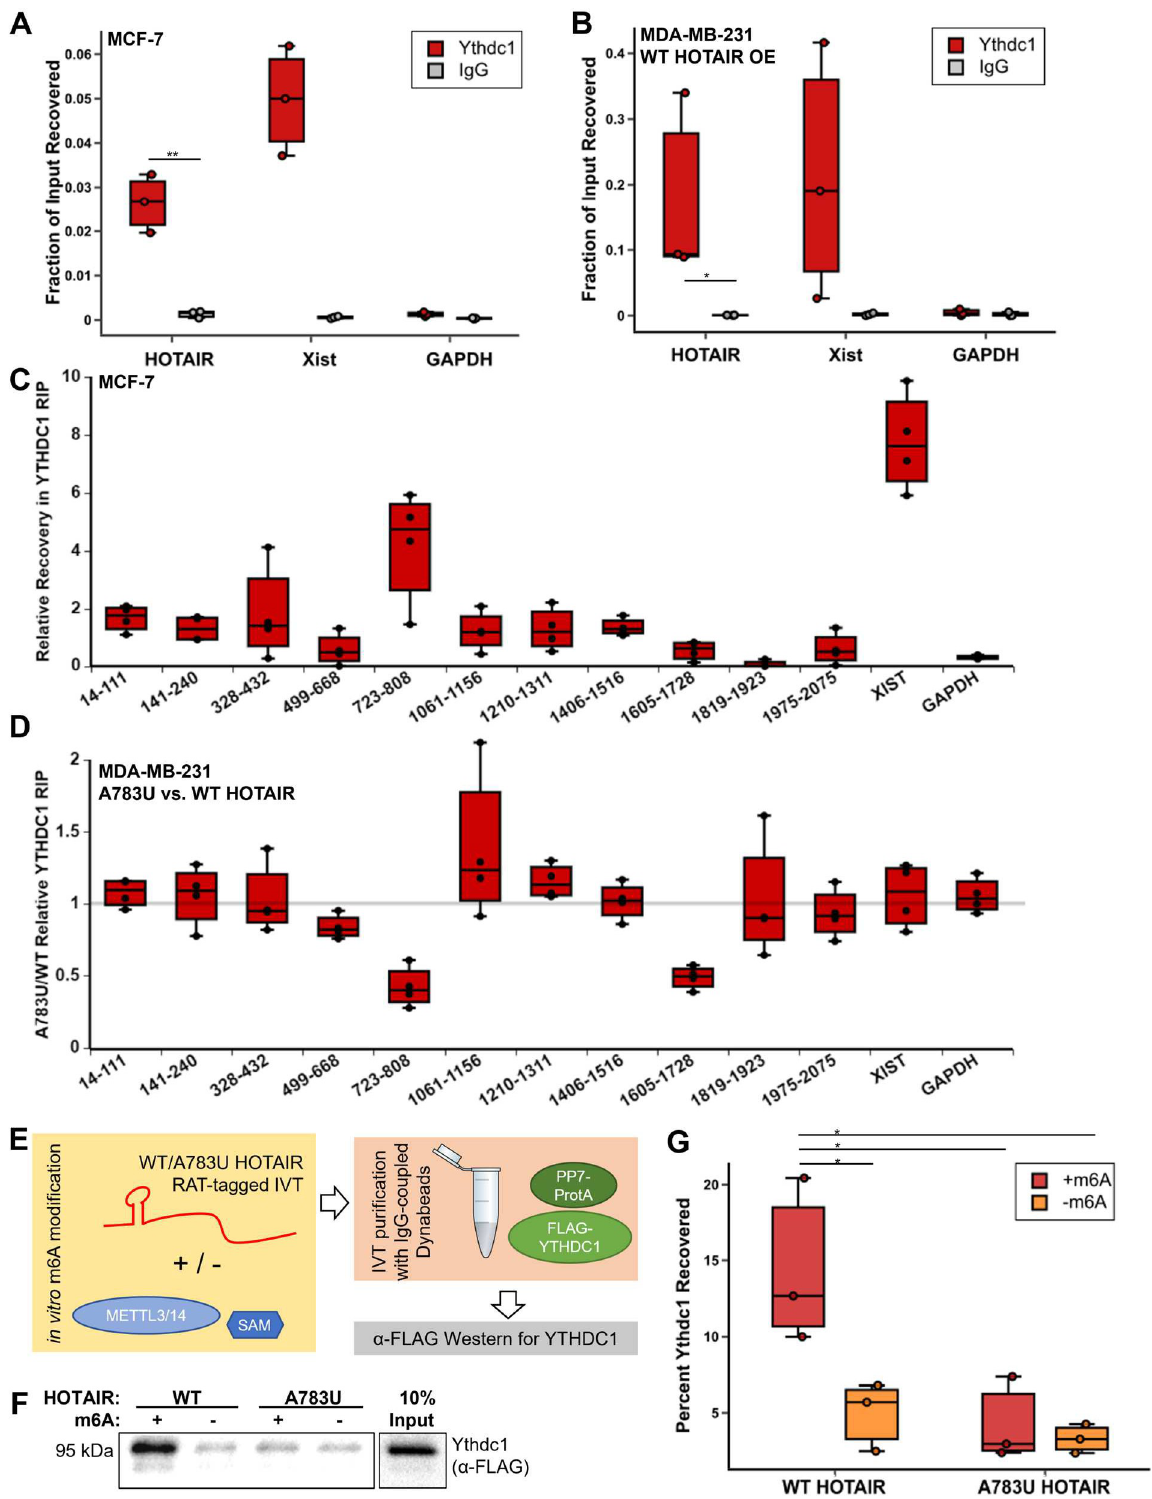
Fig 2. YTHDC1 interacts with HOTAIR at m6A783. (A, B) YTHDC1 RIP performed in MCF-7 cells (A) or MDA-MB-231 cells overexpressing transgenic HOTAIR (B) on 3 biological replicates. (C) YTHDC1 RIP performed in MCF-7 cells on 4 biological replicates. RNA recovery was monitored with qPCR probes noted in graph and normalized to recovery observed with qPCR oligos targeting a region of